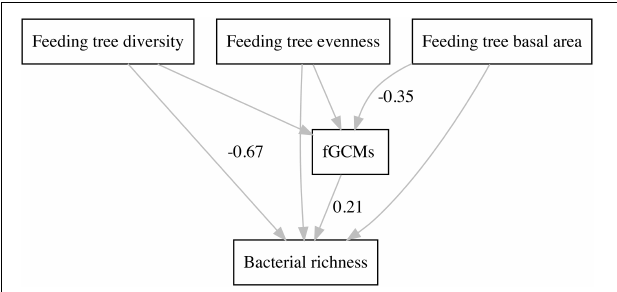
FIGURE 2 | Path diagram from structural equation modeling, showing direct and indirect effects of food availability and physiological stress indices on bacterial richness of black howler monkeys ( Alouatta pigra ) inhabiting disturbed forest fragments at Escárcega, State of Campeche, Mexico. Standardized regression coefficients of significant paths are